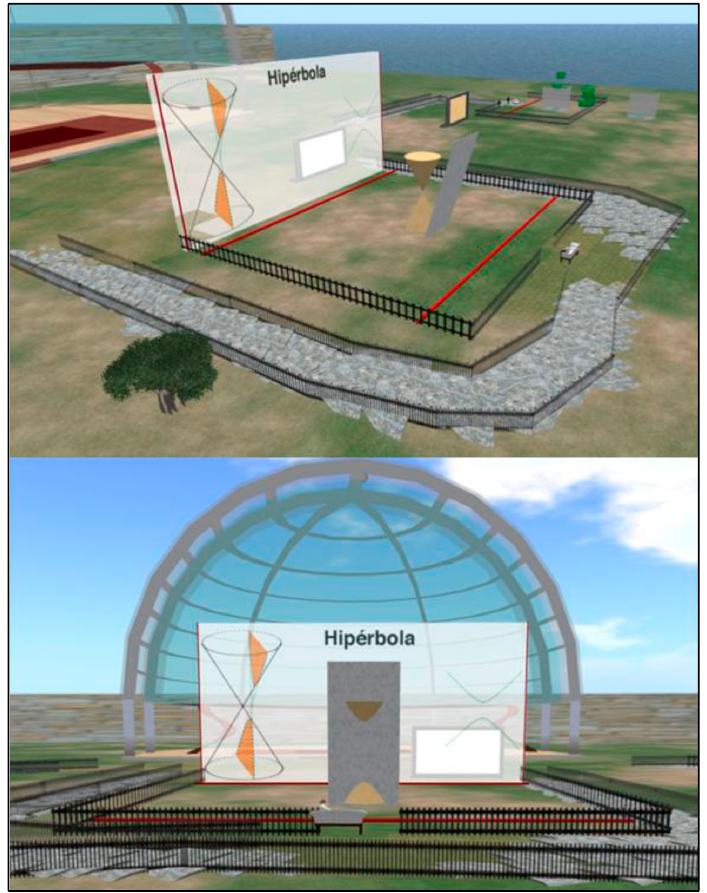
Figure 2. Two views of the virtual elements for teaching conic sections.